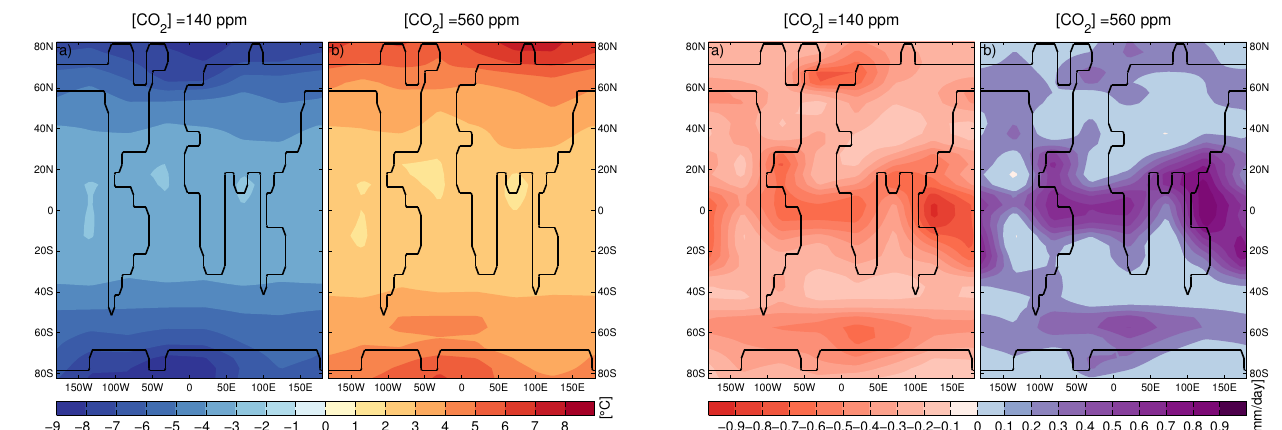
× CO × CO 2 and (b) 2 2 for 2